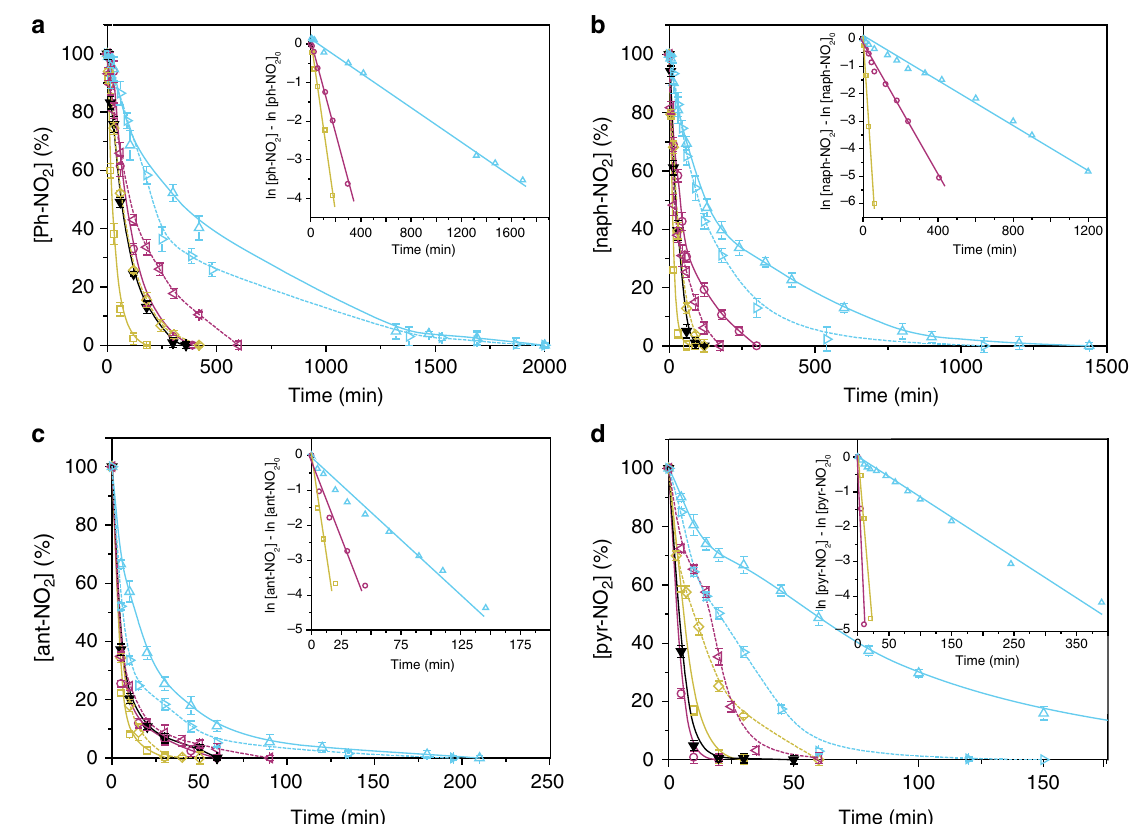
Fig. 3 Catalysts ’ activity. Kinetics of the reduction of a Ph-NO 2 , b naph-NO 2 , c ant-NO 2 , d pyr-NO 2 catalyzed by MINT-exTTF (yellow solid line), MINT-pyr (purple solid line), MINT-AQ (cyan solid line), 6,5-SWNT (black solid line), SWNT-exTTF (yellow dashed line), SWNT-pyr (purple dashed line), and SWNT-AQ (cyan dashed line). Error bars are standard deviation from three separate